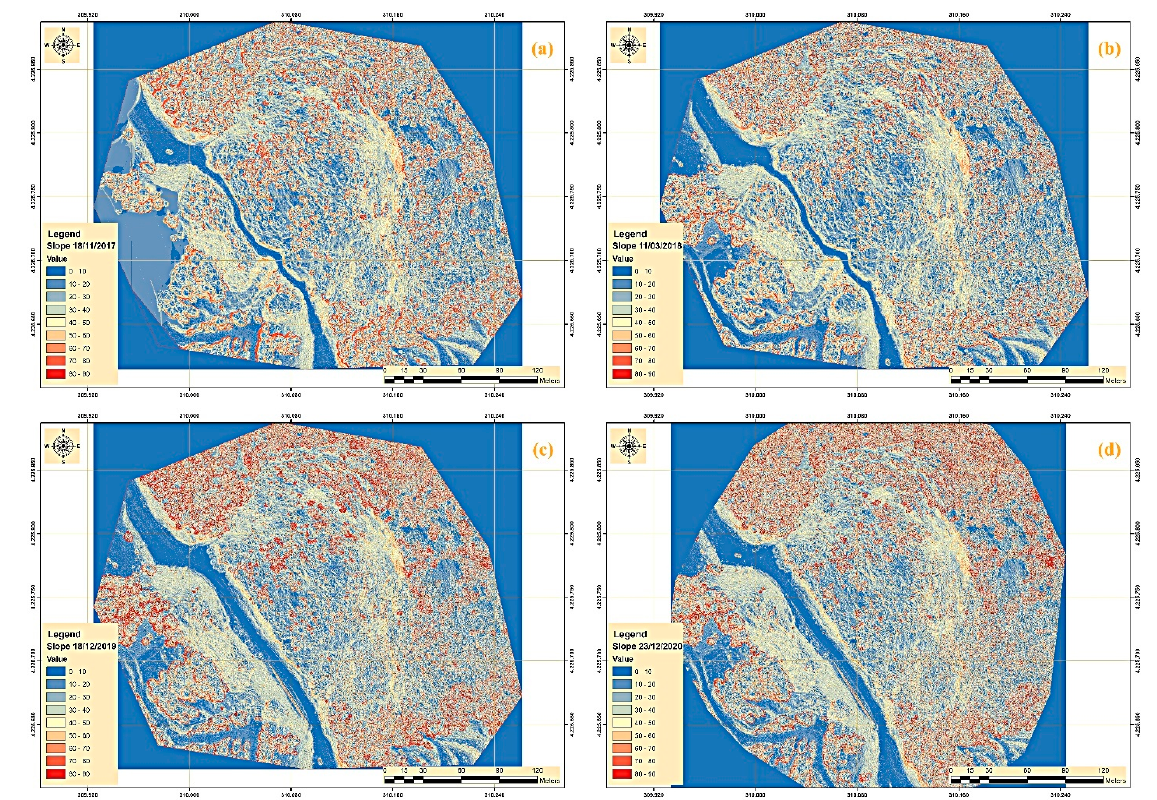
Figure 20. The evolution of the slope in the study area between 2017 and 2019. ( a ) The slope of the landslide area in 2017. ( b ) The slope of the landslide area in 2018. ( c ) The slope of the landslide area in 2019. ( d ) The slope of the landslide area in 2020.